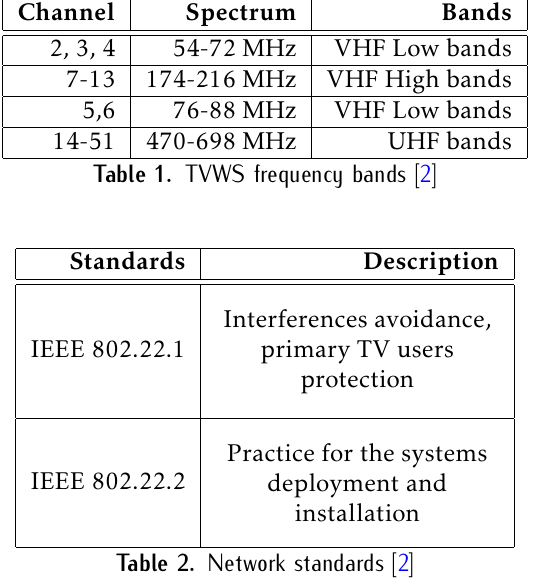
Figure 1. Operating diagram of a cognitive radio node